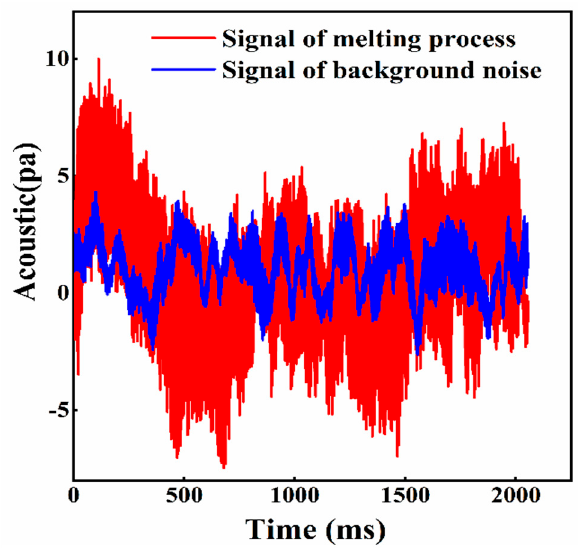
Figure 6. Acoustic signals collected of ambient noise (laser shutdown) and melting process (scanning speed 30 mm/s and laser power 200 W).